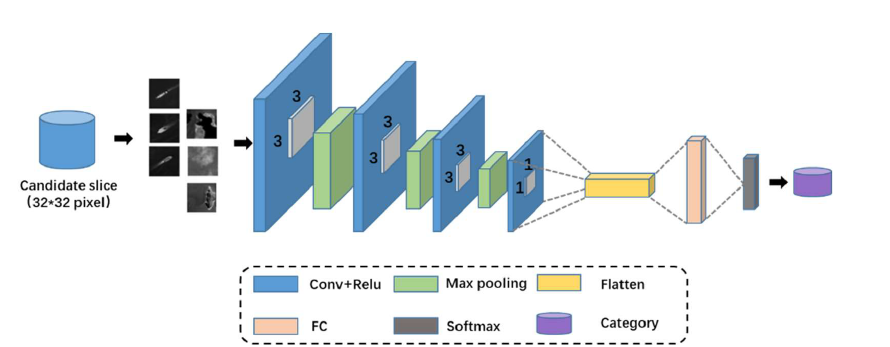
Figure 7. Schematic of feature extraction through a lightweight CNN.